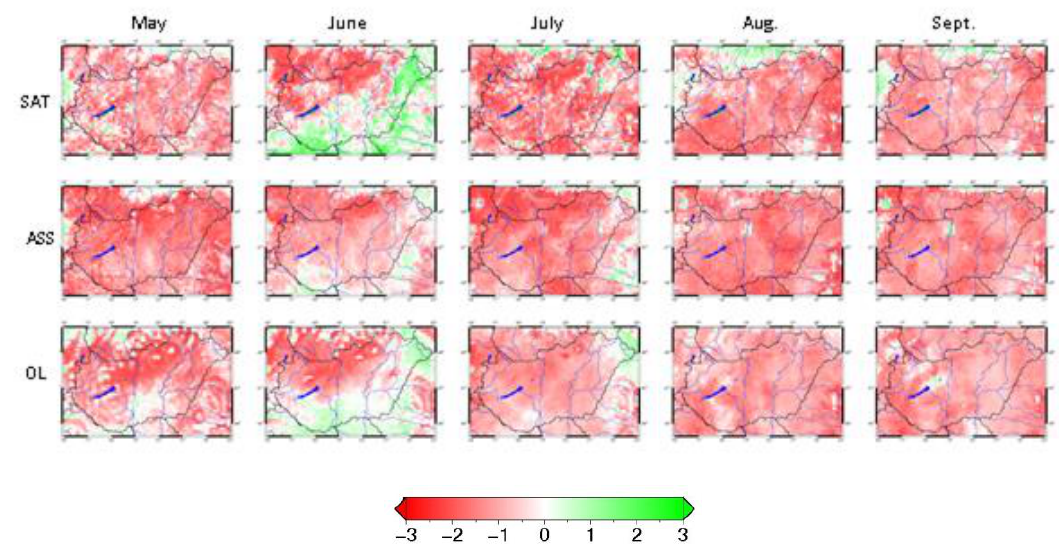
Figure 7. Monthly anomalies for the year 2012 from May to September: GEOV1 LAI product (first row), assimilated LAI (second row) and open-loop LAI (third row).